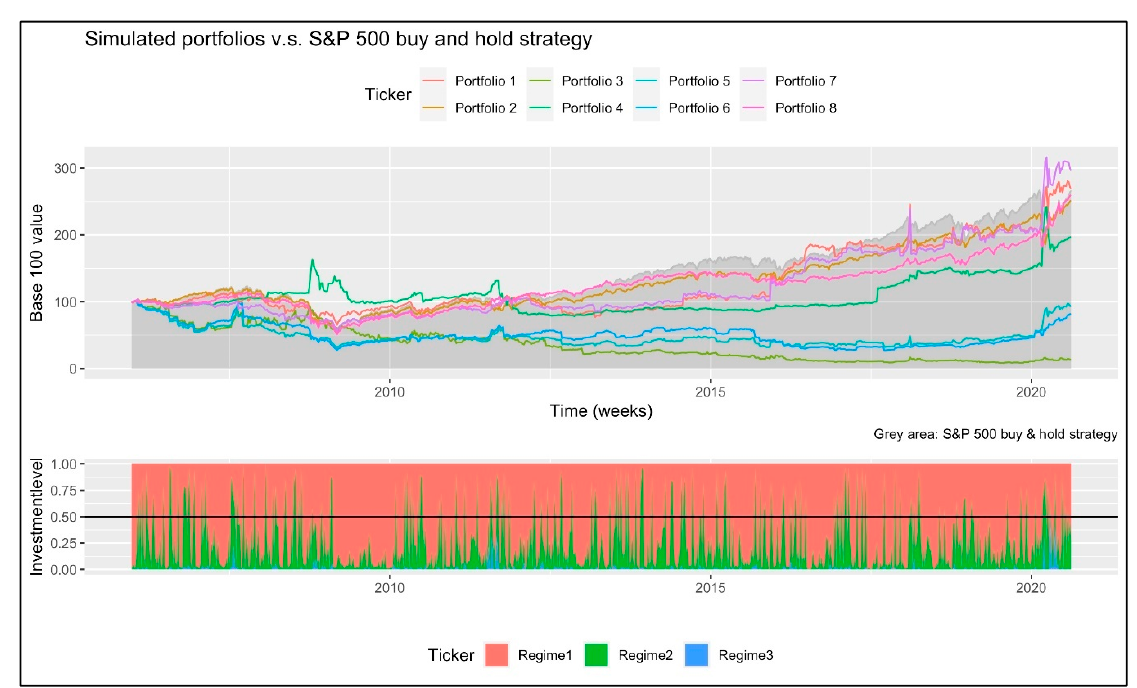
Figure 5. The historical performance of the 8 simulated portfolios of an Institutional investor that pays VIX future roll-over costs and a monthly 0.83% stock trading fee plus VAT. Source: Own elaboration with data from Refinitiv [16].